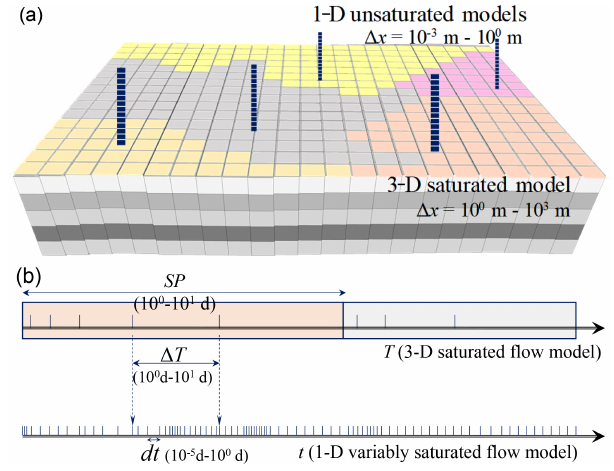
Figure 1. Schematic of the space- and time-splitting strategy for coupling models at two independent scales. For a groundwater model, spatial discretization is expected to be large ( (cid:49)x = 10 0 – 10 3 m), while for soil-water models, it is small ( (cid:49)x = 10 − 3 – 10 0 m). Multiple levels of temporal discretization are common for regional problems. For the groundwater model, the stress periods (SP) and macro-time-step sizes ( (cid:49)T ) appear in months and days (10 0 –10 1 days). For soil-water models, the time-step sizes are about 10 − 5 –10 0